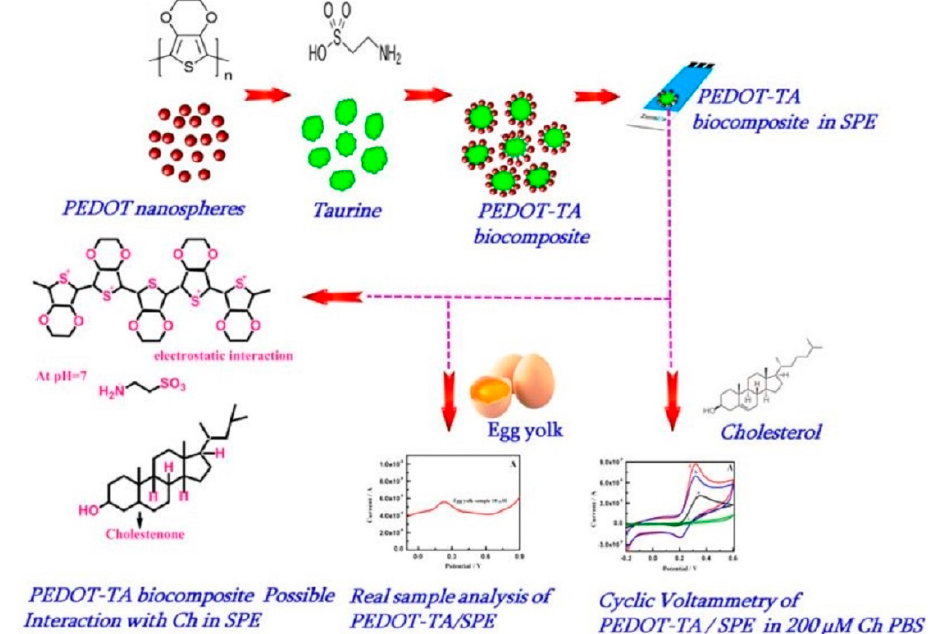
Figure 16. Schematic preparation of PEDOT-TA hybrid biocomposite selective sensing of cholesterol with possible interaction mechanism. Reprinted with permission from Ref. [99].